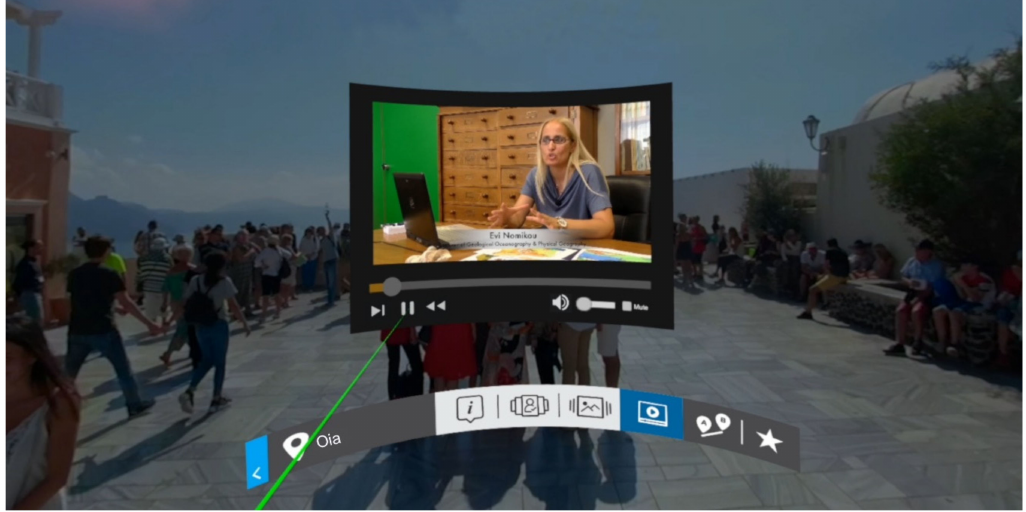
Figure 16. Walk Mode: Central square of Oia city—the Video Interaction Component is